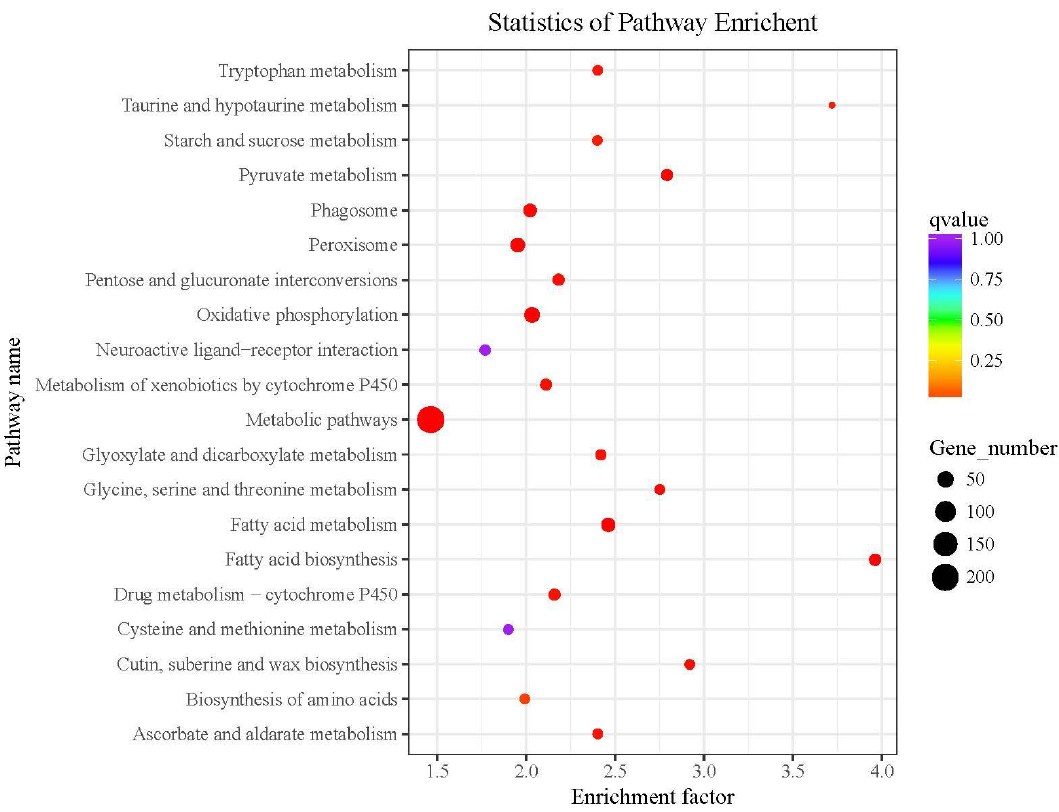
Figure 4. KEGG cluster map of differentially expressed genes detected by RNA-seq. The red boxes indicate the pathways we focus on.